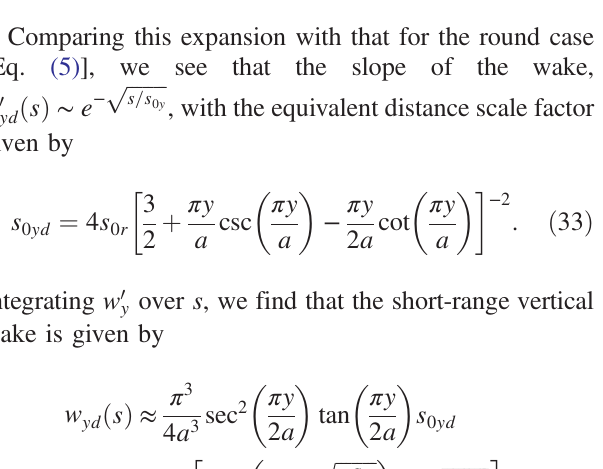
FIG. 9. Dipole bunch wake for a Gaussian beam on axis, with σ ¼ 10 μ m, in the RadiaBeam/LCLS dechirper. Given are the z numerical results of ECHO(2D) (blue), and the analytical zeroth order (red) and 1st order results (green). The bunch shape λ ð s Þ with the head to the left is shown in